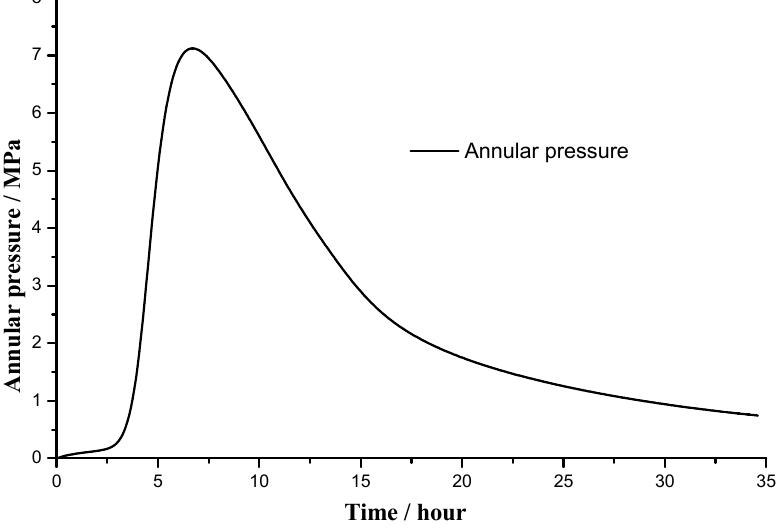
Figure 11. Transient development of annular pressure.